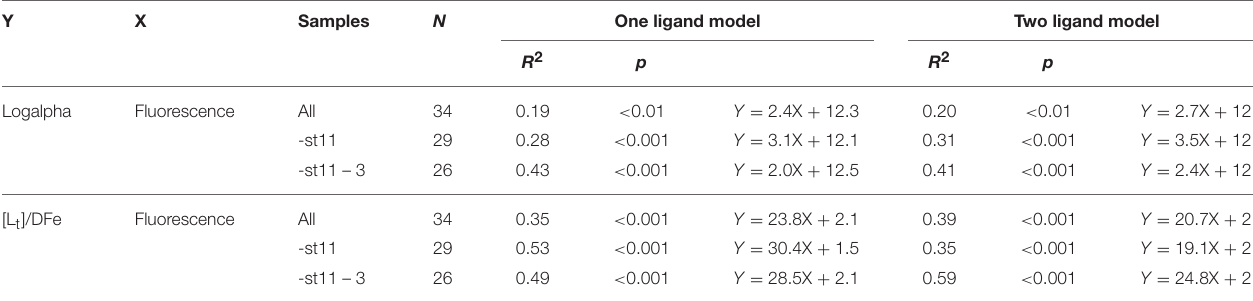
[L t ]/DFe Fluorescence All 34